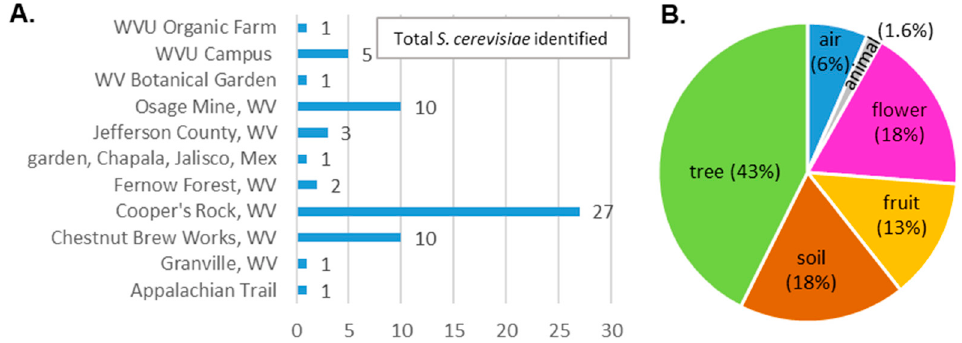
Figure 4. Characterization of S. cerevisiae isolation. ( A ) Distribution of S. cerevisiae isolated from different locations. ( B ) Distribution S. cerevisiae isolated from different sources.